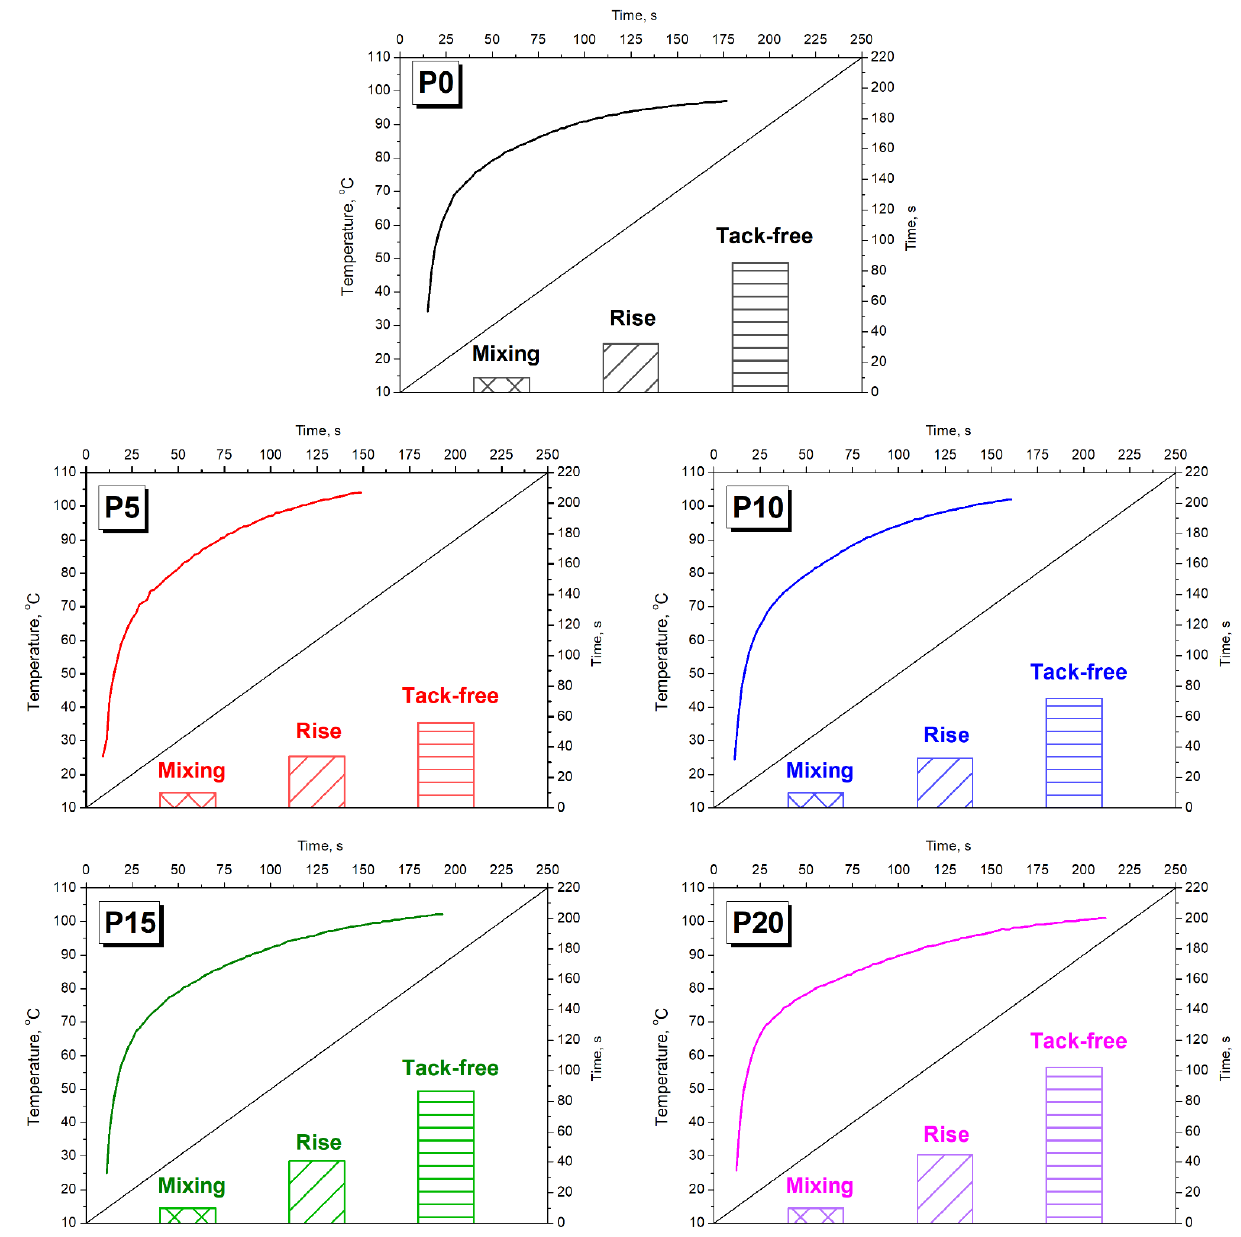
Figure 2. The impact of GTR addition on the processing times (shaded areas) and temperature (curves) reached by the core of foam during volumetric expansion.